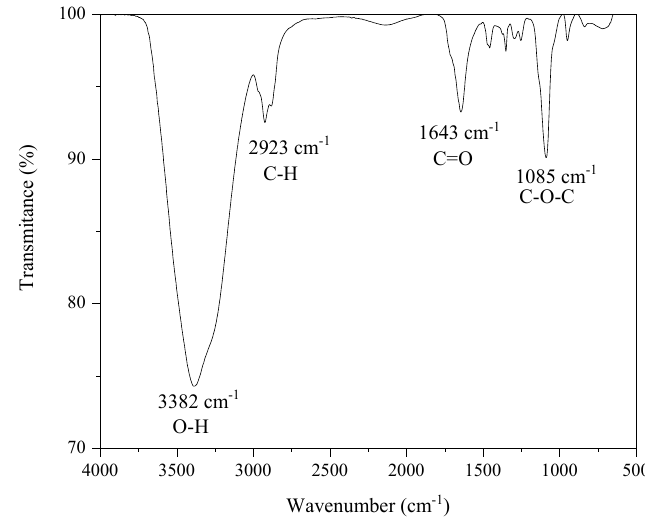
Figure 2. FTIR spectrum of the polycarboxylate-based superplasticizer used.